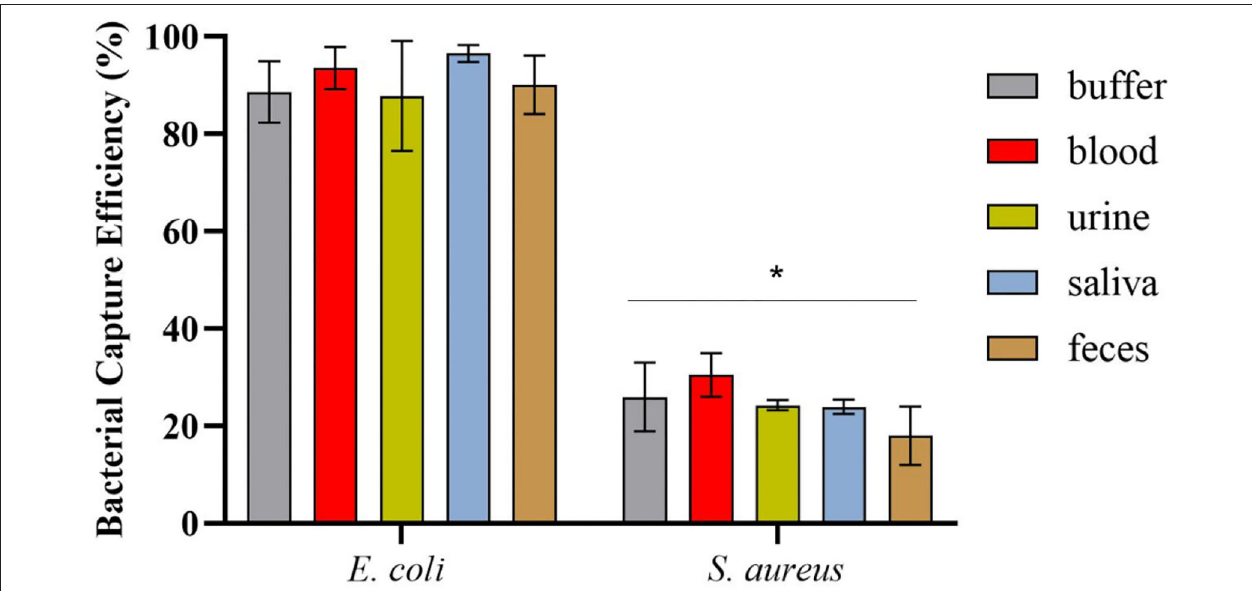
FIGURE 4 | Bacterial capture efficiencies (in percentage) obtained in the magnetic sandwich assay performed in the different types of human specimens for E. coli HB104 (target bacteria) and S. aureus HB22 (non-target bacteria), assessed by CFU counting. Errors bars represent the standard deviation of the average of three independent experiments ( n = 3). *Statistical analysis was performed comparing the percentage of bacterial capture obtained for the target bacteria E. coli and the negative control S. aureus in each of the human specimens. Multiple comparisons were done using the two-way ANOVA with Sidak’s multiple comparison test ( p- value < 0.0001).